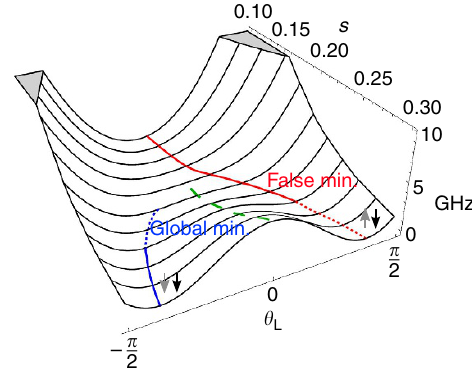
Figure 2 | Effective energy potential using h L ¼ 0.44. The mean field potential is plotted versus annealing parameter s and tilt angle y L of each spin vector in the left cluster. The red line corresponds to a path that starts in the initial global minimum and follows the instantaneous local energy minimum. A second local minimum (dashed blue line) forms at the Figure 1 | Graph of the tunnelling probe Hamiltonian. The 16 qubits are bifurcation point s ¼ 0.18. The global minimum is found in this second path coupled ferromagnetically with J ¼ 1 (lines). The applied fields are after s ¼ 0.24 (dashed to continuous blue line). To reach this global 0 o h L o J /2 ( h R ¼ (cid:2) 1) for the left (right) qubit cell. The symmetry and minimum the system state has to traverse the energy barrier between them strong intracell ferromagnetic coupling makes each 8-qubit cluster evolve (dashed green line), either by thermal activation or by quantum tunnelling. together. NATURE COMMUNICATIONS|7:10327|DOI: